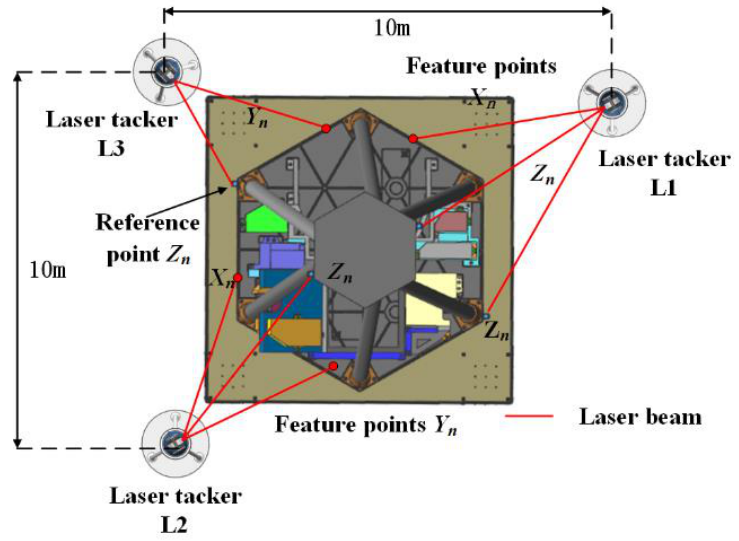
Figure 10. Diagram of theodolite angle intersection measurement.